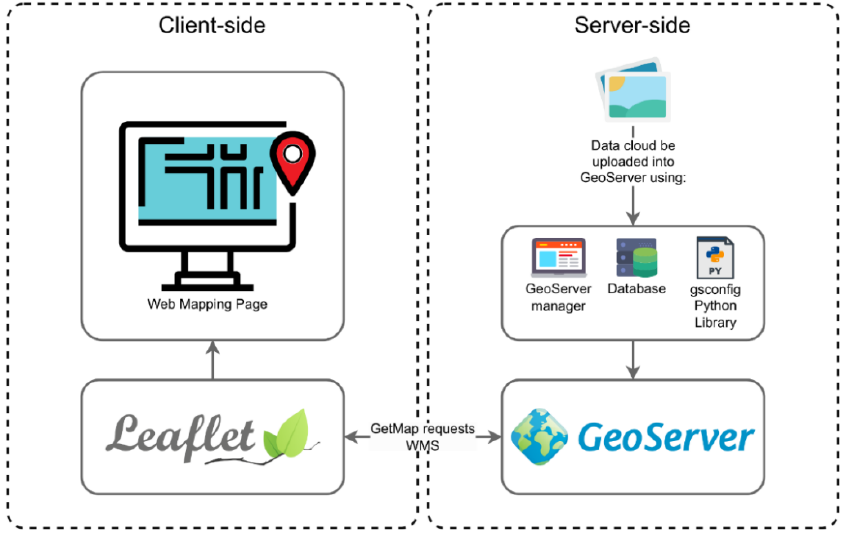
Figure 6. GeoServer and Leaflet integration.